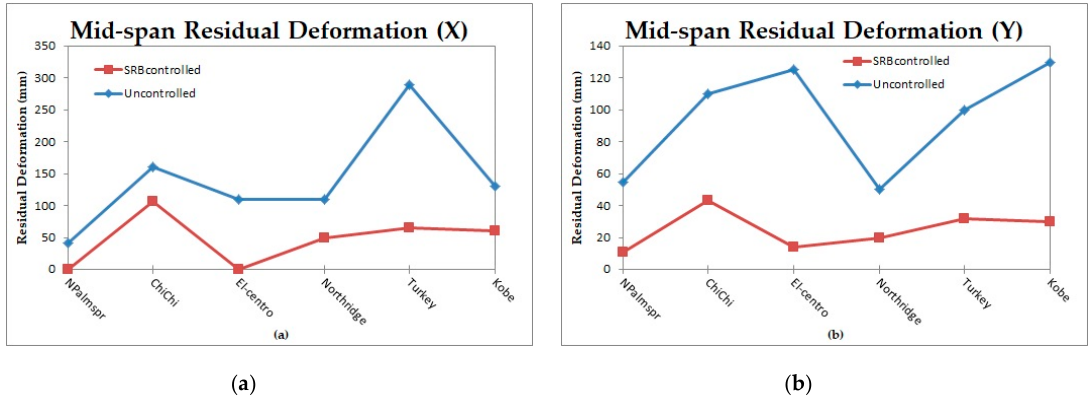
Figure 11. Graphical demonstration of the mid-span residual deformation before and after the SRBs in